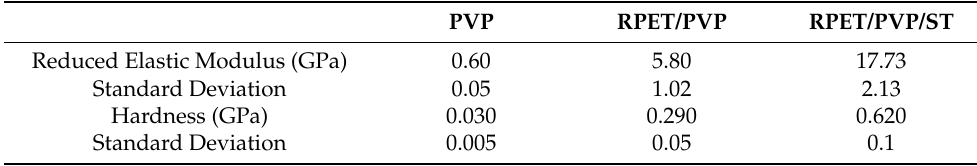
Table 1. Reduced moduli and hardnesses of PVP, RPET/PVP, and RPET/PVP/ST nanofibers. PVP RPET/PVP RPET/PVP/ST Reduced Elastic Modulus (GPa)